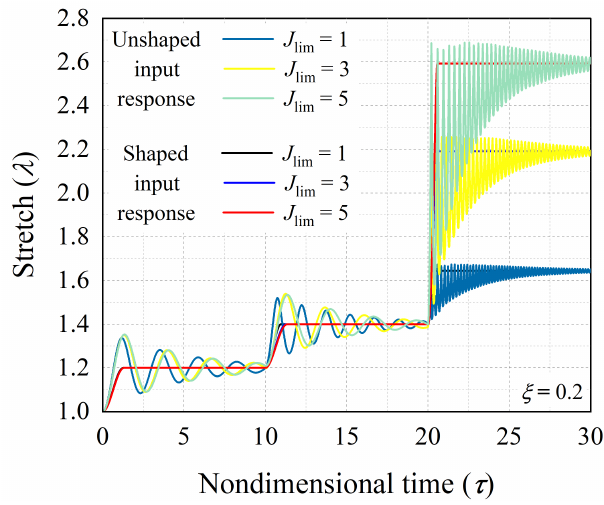
Figure 8. Effect of material damping on the nondimensional intermediate time ( τ p ) required for attaining the desired equilibrium position.